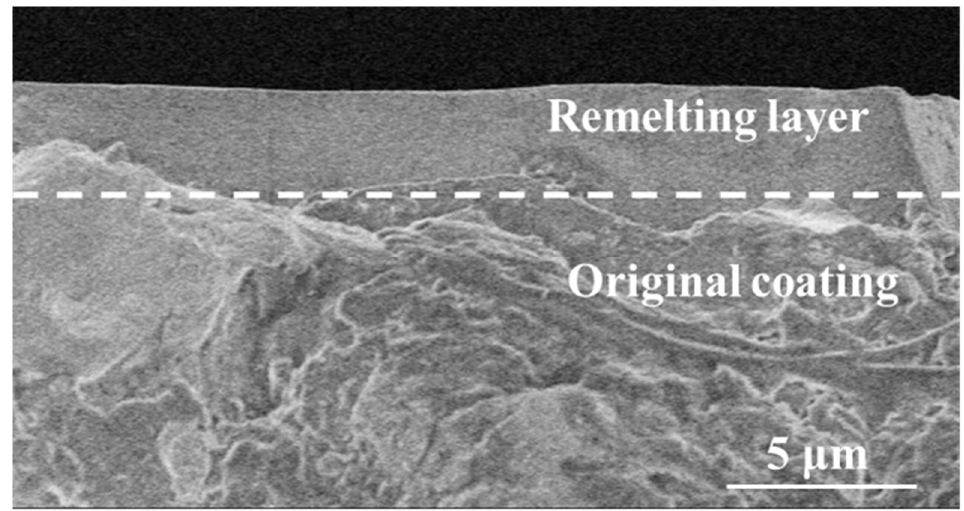
Figure 3. Cross ‐ sectional morphology of the NiCrAlY coating irradiated by a high ‐ current pulsed Figure 3. Cross-sectional morphology of the NiCrAlY coating irradiated by a high-current pulsed electron beam with an electron beam with an energy density of 18 J/cm 2 . energy density of 18 J/cm 2 .